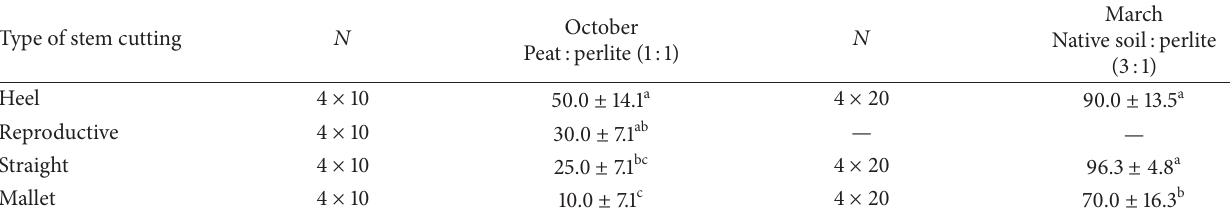
Table 6: Rooting percentages obtained on different types of cuttings of Calluna vulgaris under a photoperiod of 16h and a temperature regime of 20 ∘ C. Mean values ± standard deviations. In each column, groups that showed significant differences ( 𝑃 < 0.05 ) are indicated with different letters.